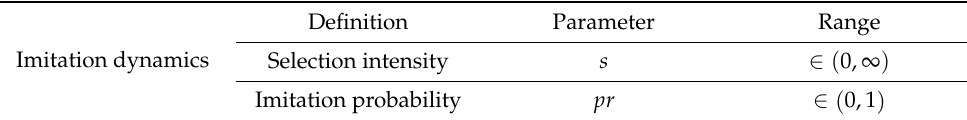
Table 4. Imitation parameter